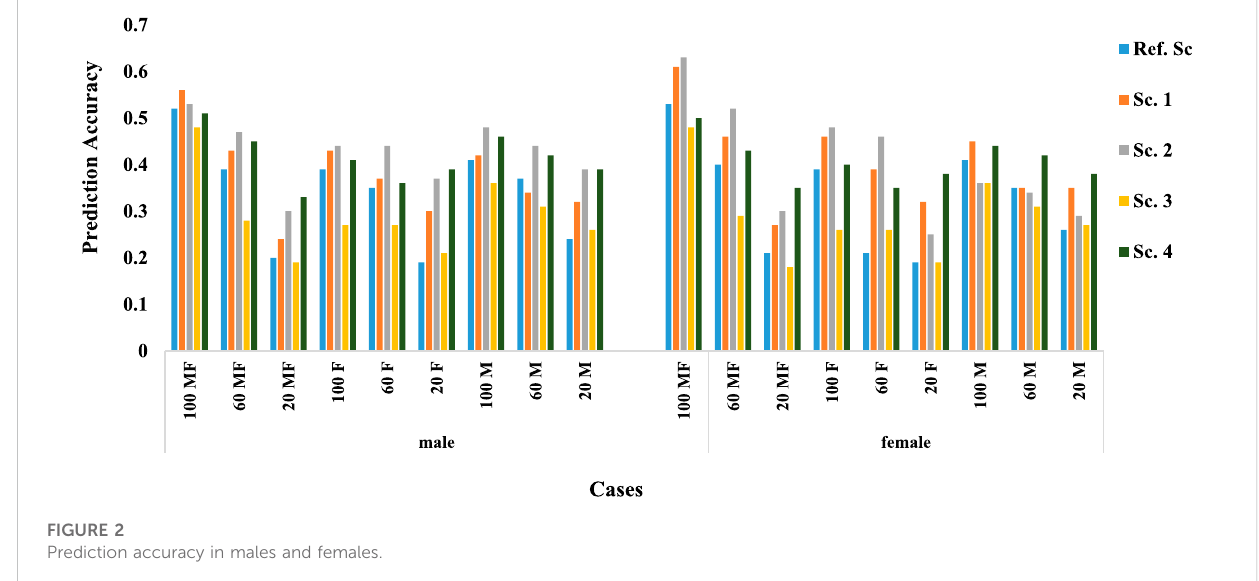
FIGURE 2 Prediction accuracy in males and females.